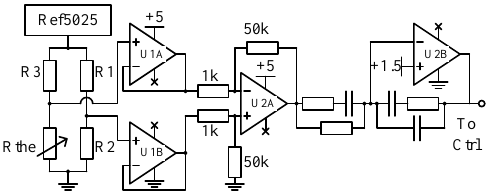
Figure 5. The VCSEL temperature control circuits.